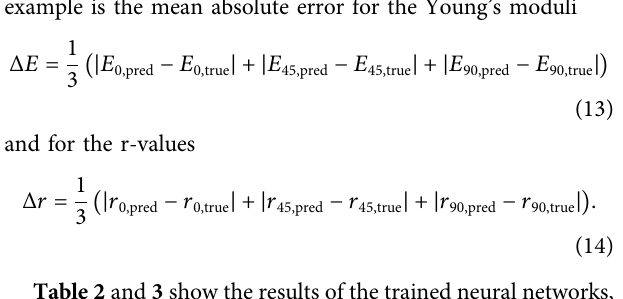
Table 2 and 3 show the results of the trained neural networks, when tested on the generated data. Training and test runs were performed fi ve times with different random validation splits. The mean and maximum errors were averaged over the data set. Both tables show that the neural networks trained with data generated by query-by-committee outperform the neural networks trained with data generated on the basis of Latin hypercube design.